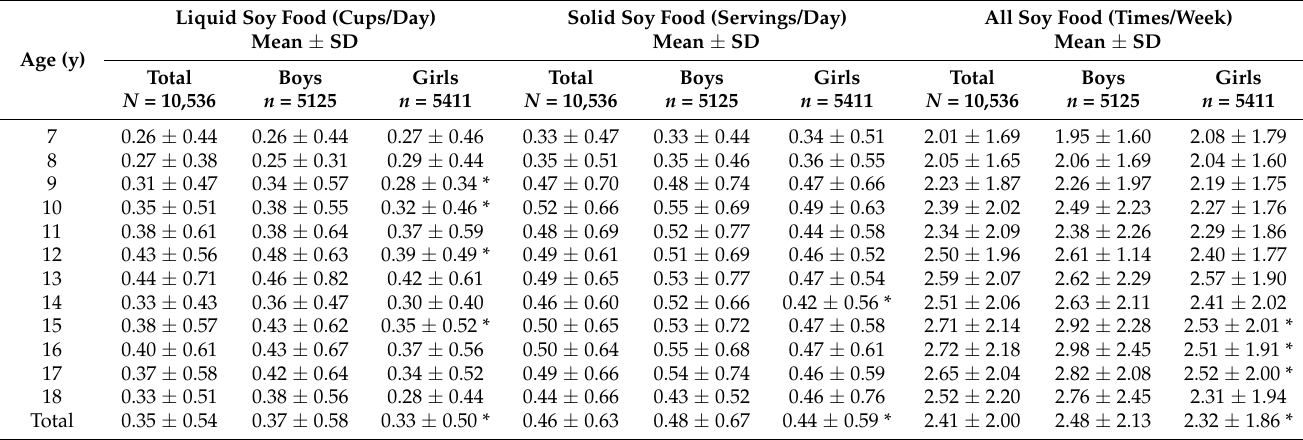
Table 1. Soy food intake in Chinese children and adolescents according to age ( n = 10,536). Liquid Soy Food (Cups/Day) Solid Soy Food (Servings/Day) Mean ± SD Mean ± SD